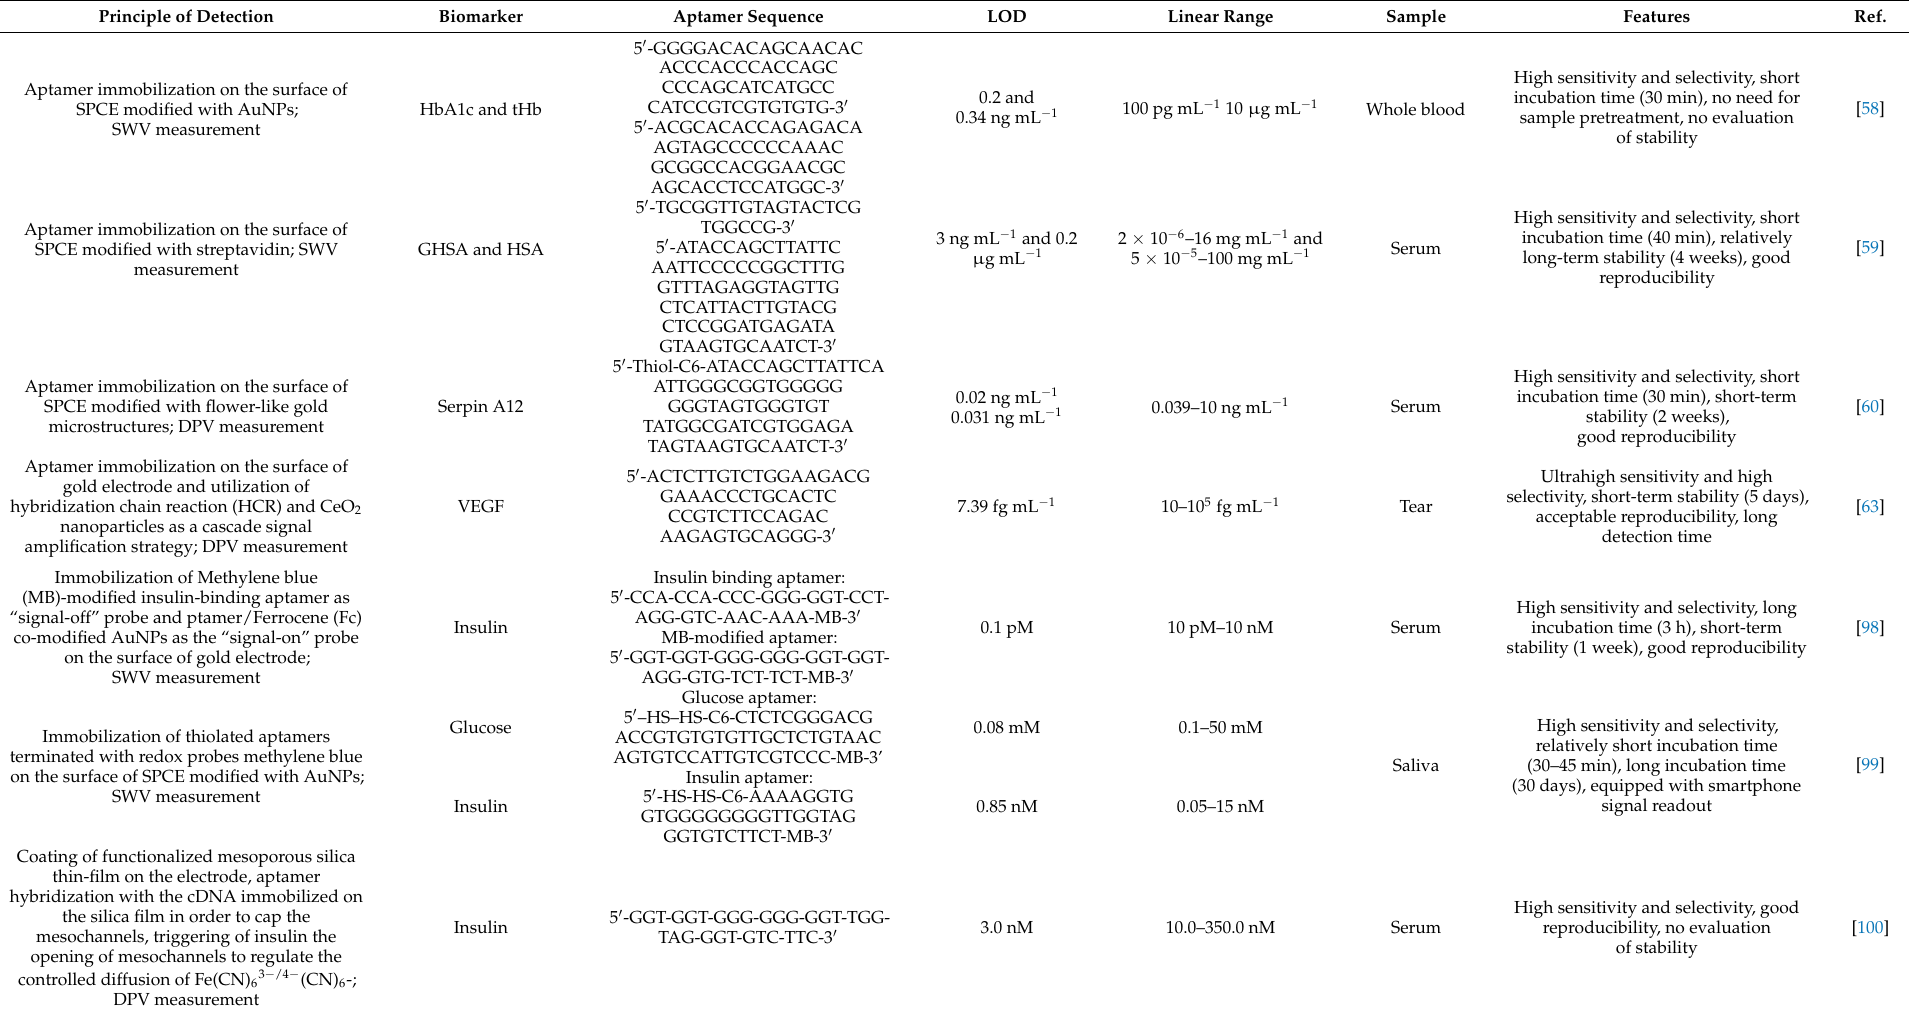
Table 6. Recent advances in electrochemical aptasensors for the detection of diabetes